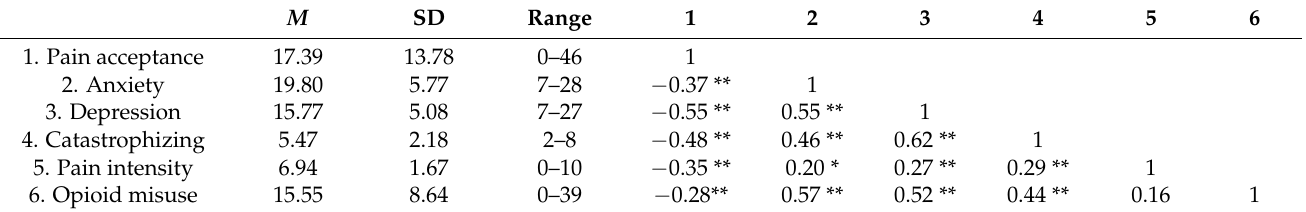
Table 1. Descriptive statistics and correlations between